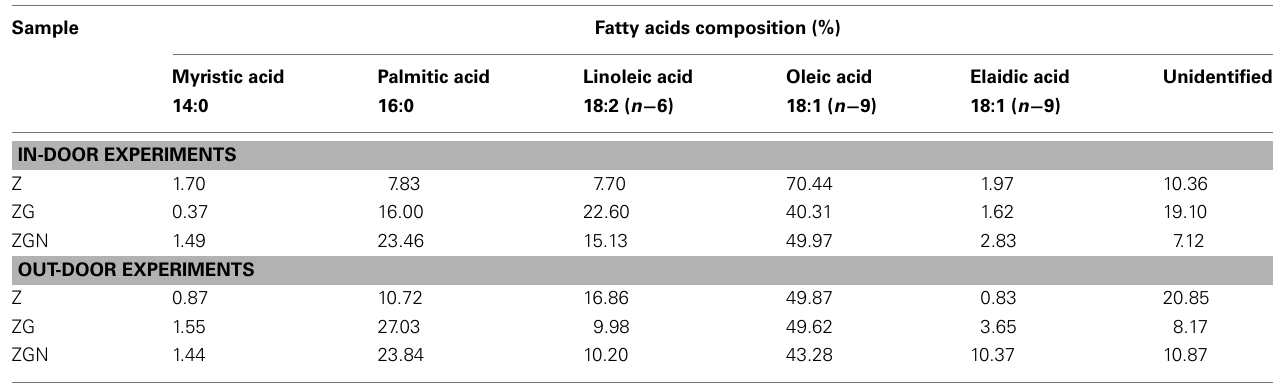
Table 7 | Fatty acid composition in the in-door and out-door cultivations for different